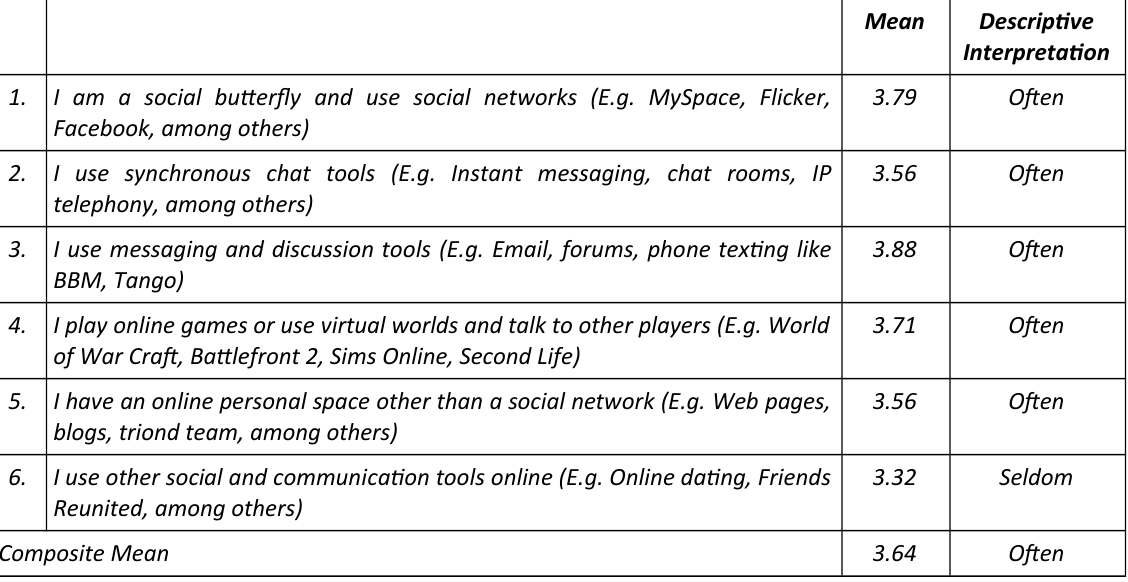
Table 1. The A-priori Learning Experiences of the Student-learners in Synchronous and Asynchronous Online Learning Activities